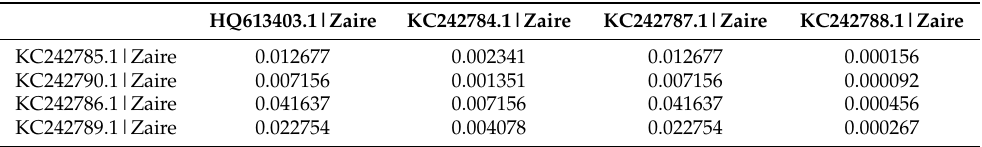
Table 2. The p-values for testing the nucleotide substitution number between sequences in the third clade for the maximum likelihood tree based on the JC69 model.